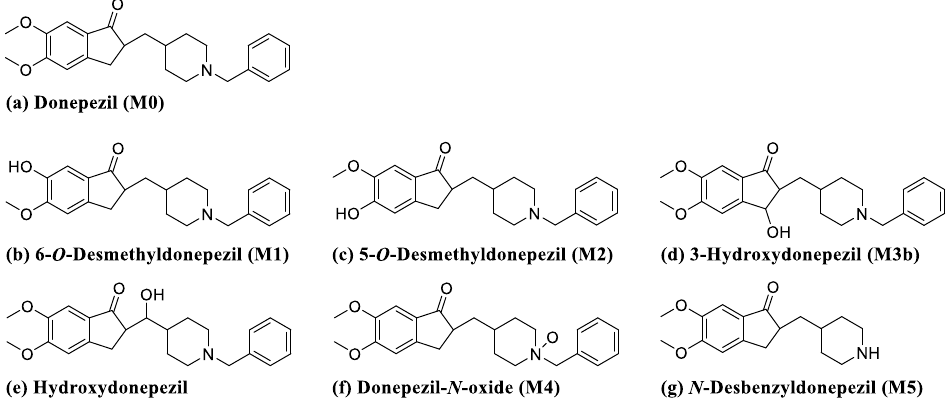
Figure 1. Chemical structures of donepezil and its commercially available metabolites.